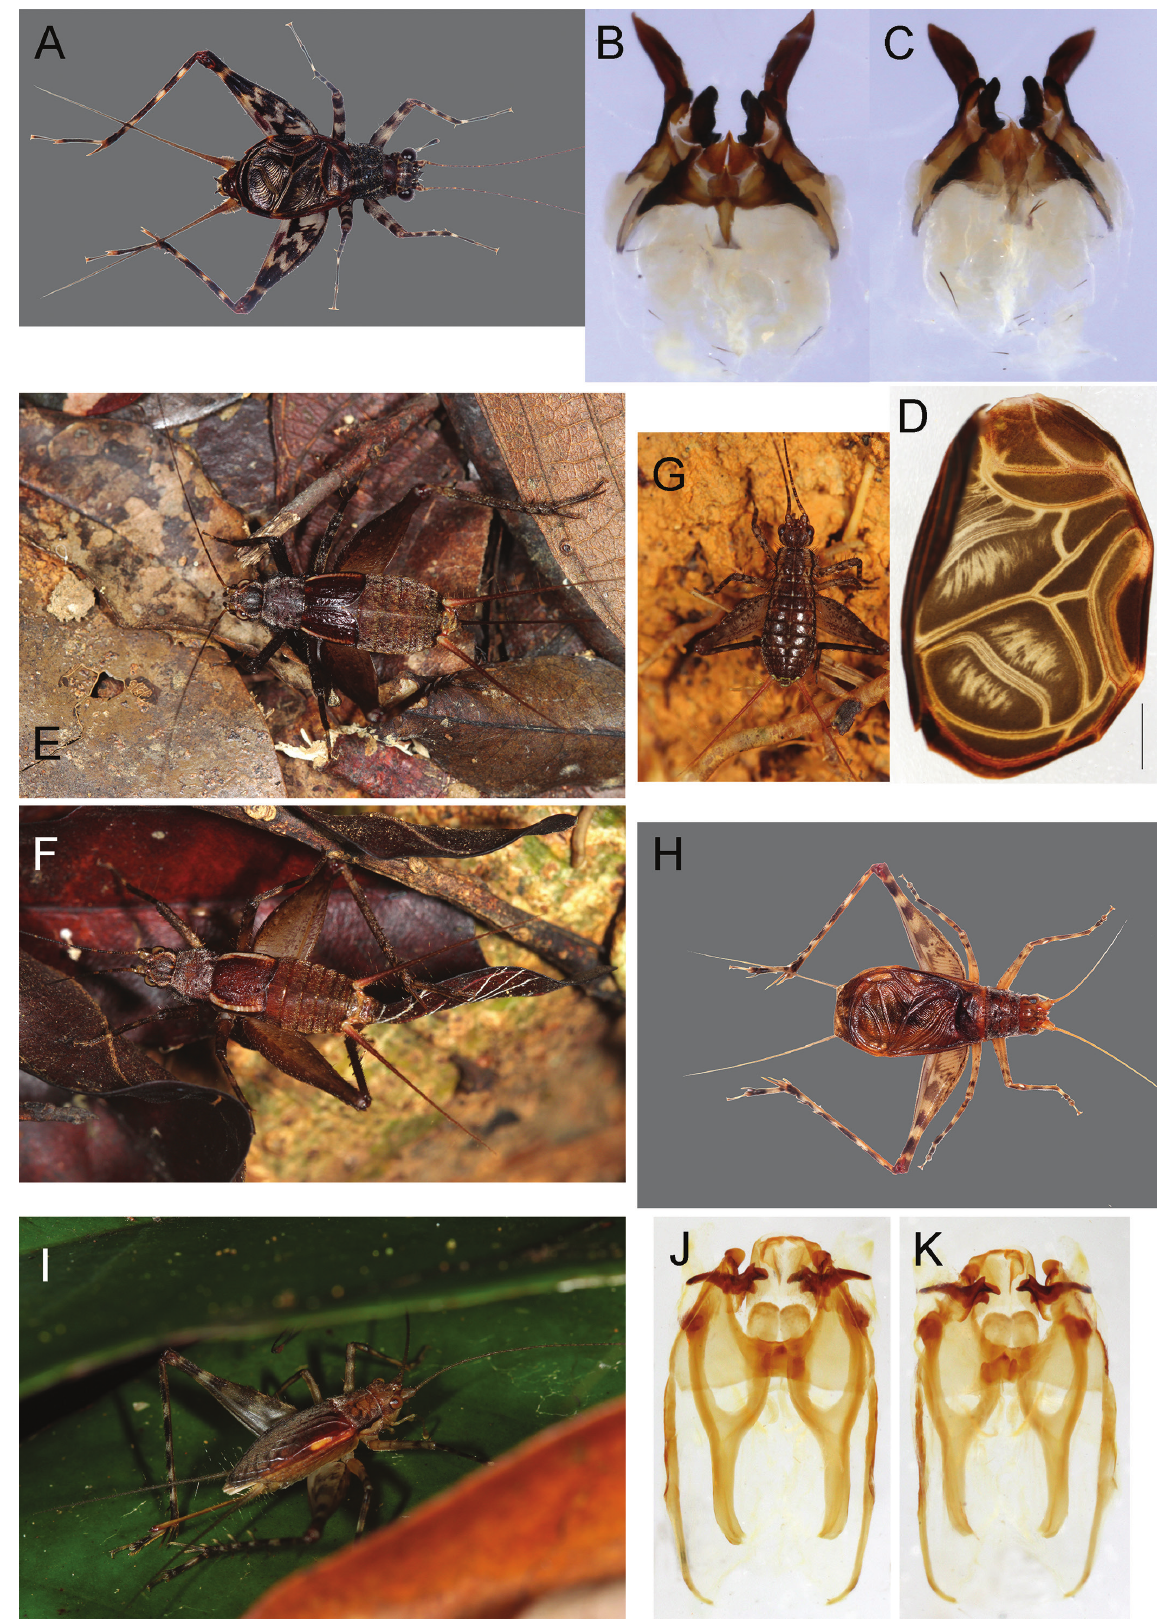
Fig. 11. Phalangopsidae: Parendacustes ( Minizacla ) mulu : A. Male; B, C. Male genitalia in dorsal and ventral views respectively; D. Male tegmen; Terrozacla borneo : E. Female; F. Male; G. Nymph; Phaloria ( Papuloria ) trista : H. Male; I. Female; J, K. Male genitalia in dorsal and ventral views respectively. Scale bar: